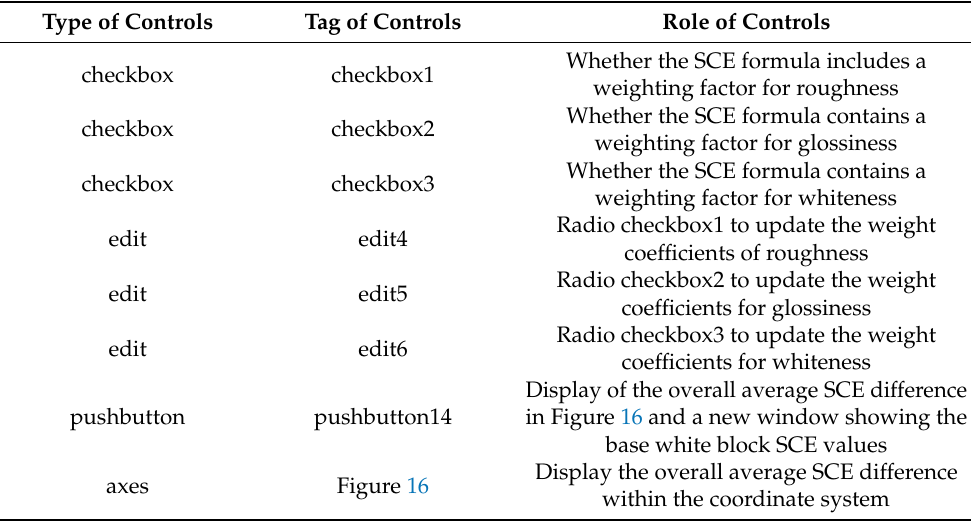
Display the overall average SCE Figure 16